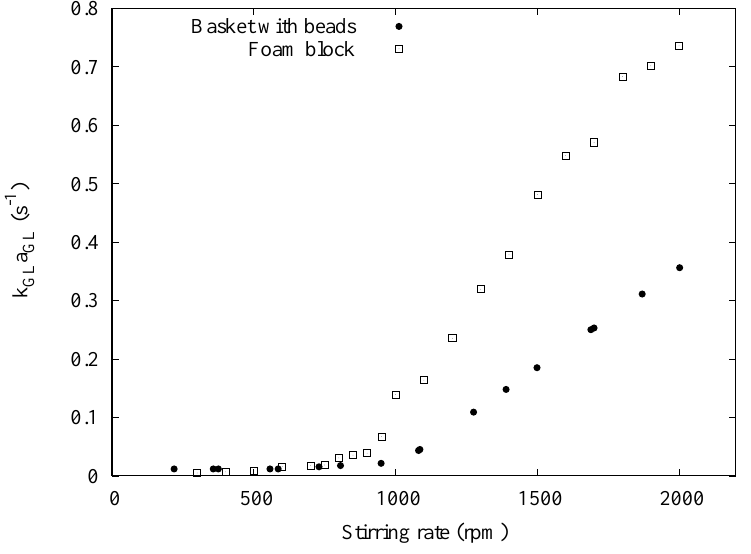
Figure 4. GL (Gas–liquid) mass transfer—comparison between the basket with 2 mm beads and the 40 PPI foam